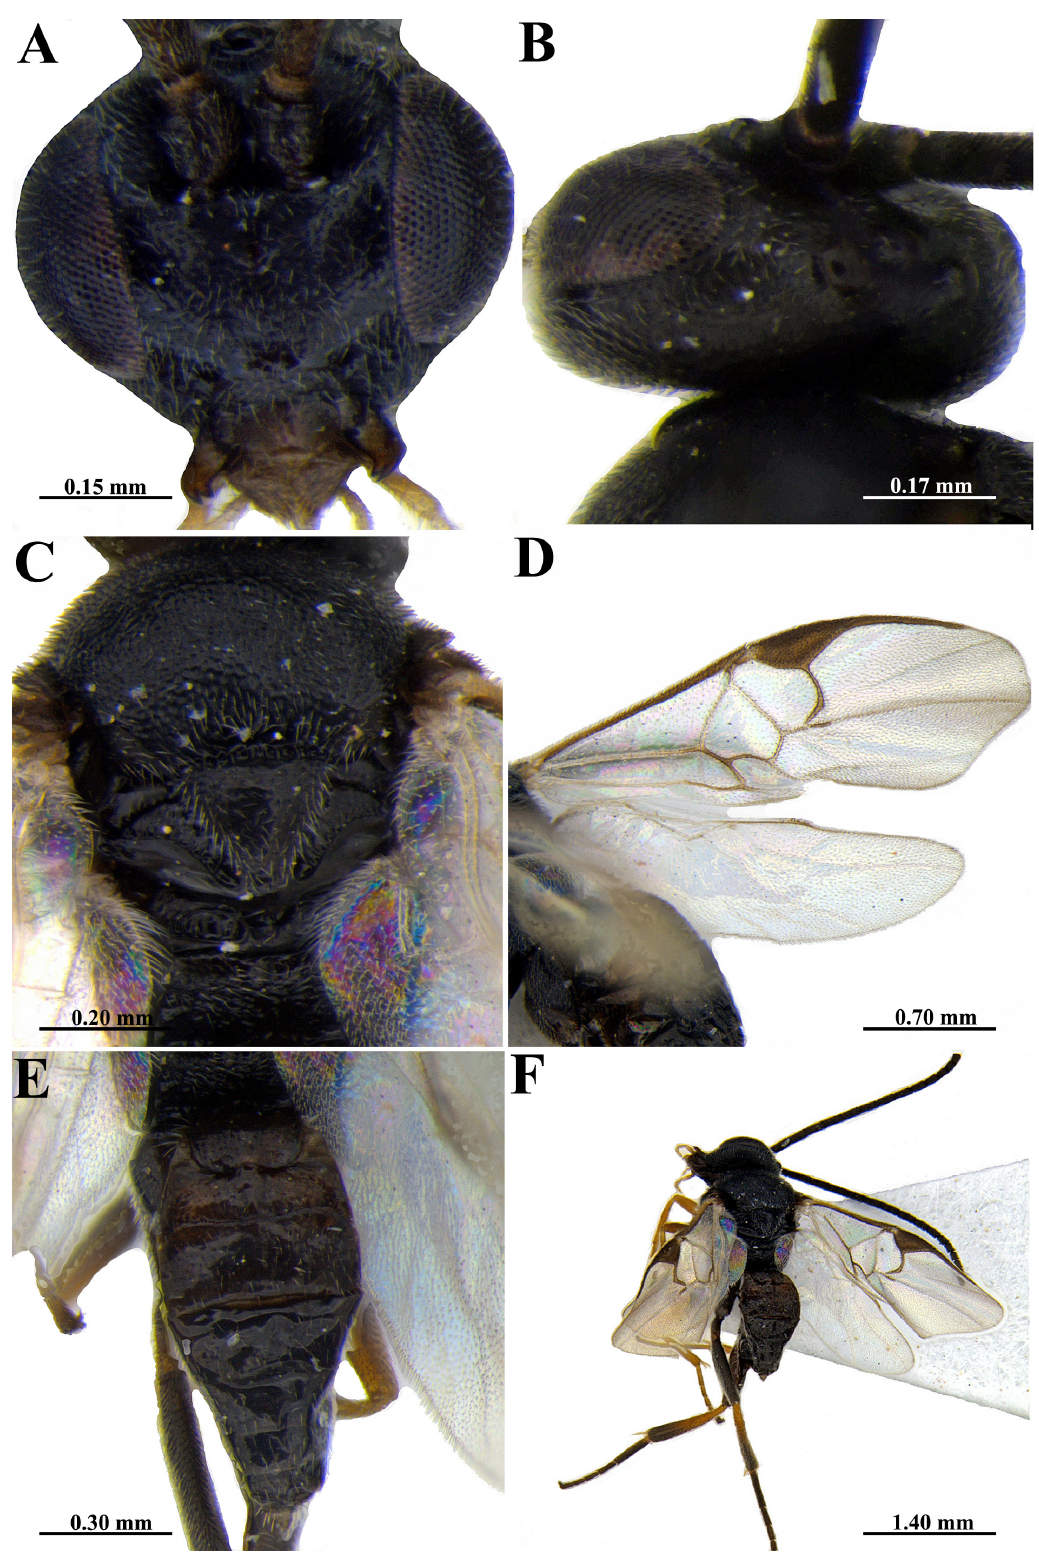
Fig. 3. Cotesia zagrosensis Zargar & Gupta sp. nov., ICAR-NBAIR/NIM/MICROG/COT/6717. A . Head, frontal view. B . Head, dorsal view. C . Mesosoma, dorsal view. D . Fore wing. E . Metasoma, dorsal view. F . Habitus, dorsal